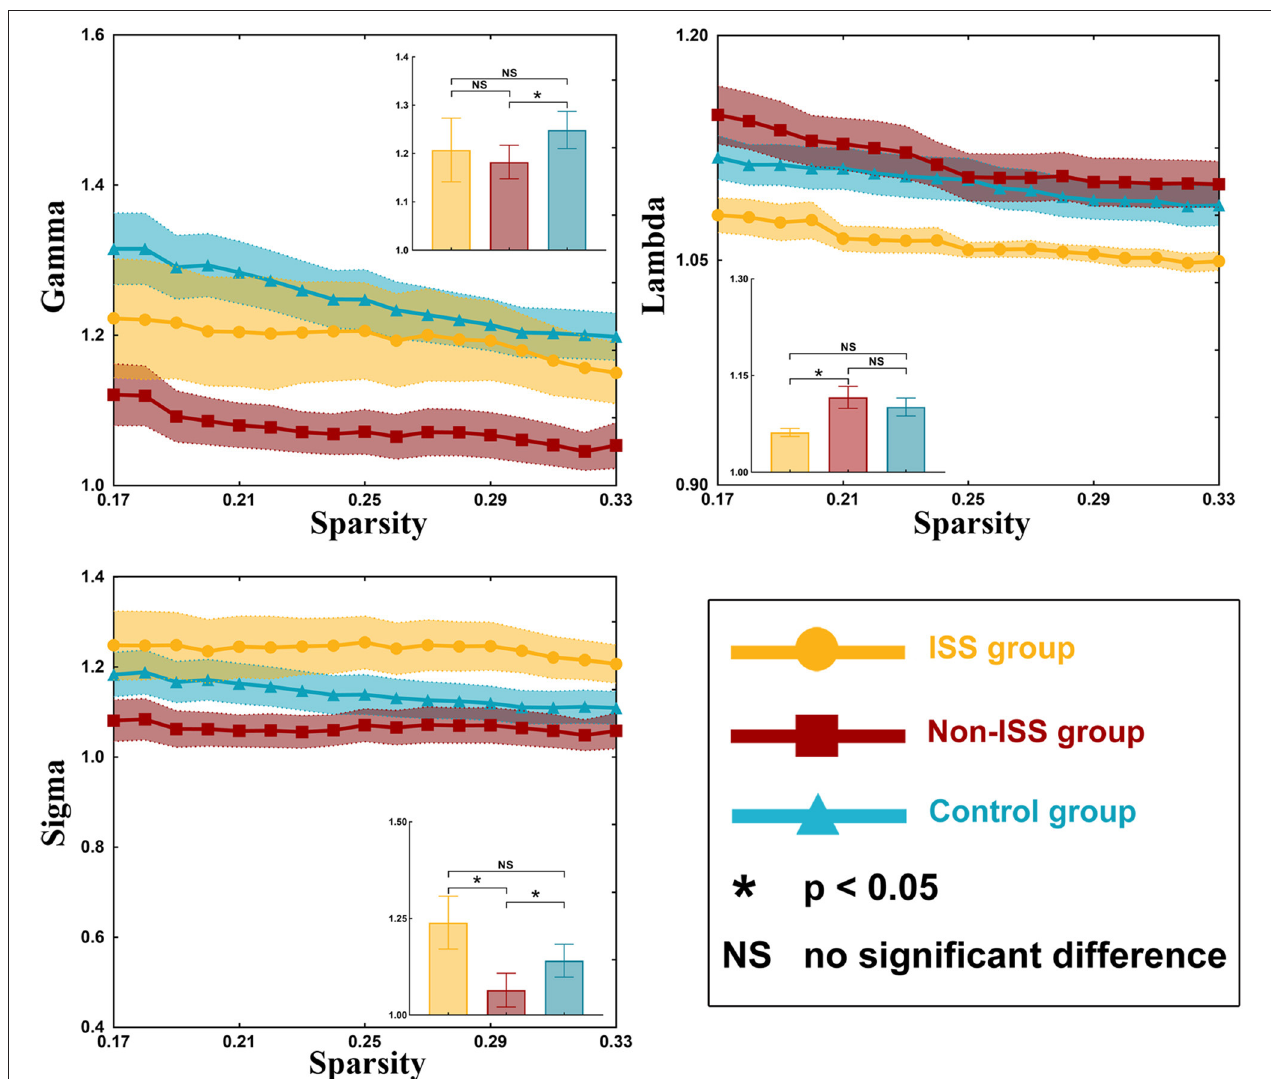
FIGURE 3 | Small-world properties of the ISS, non-ISS, and healthy groups. ISS, group of patients with intraoperative stimulation-induced seizures; Non-ISS, group of patients without intraoperative stimulation-induced